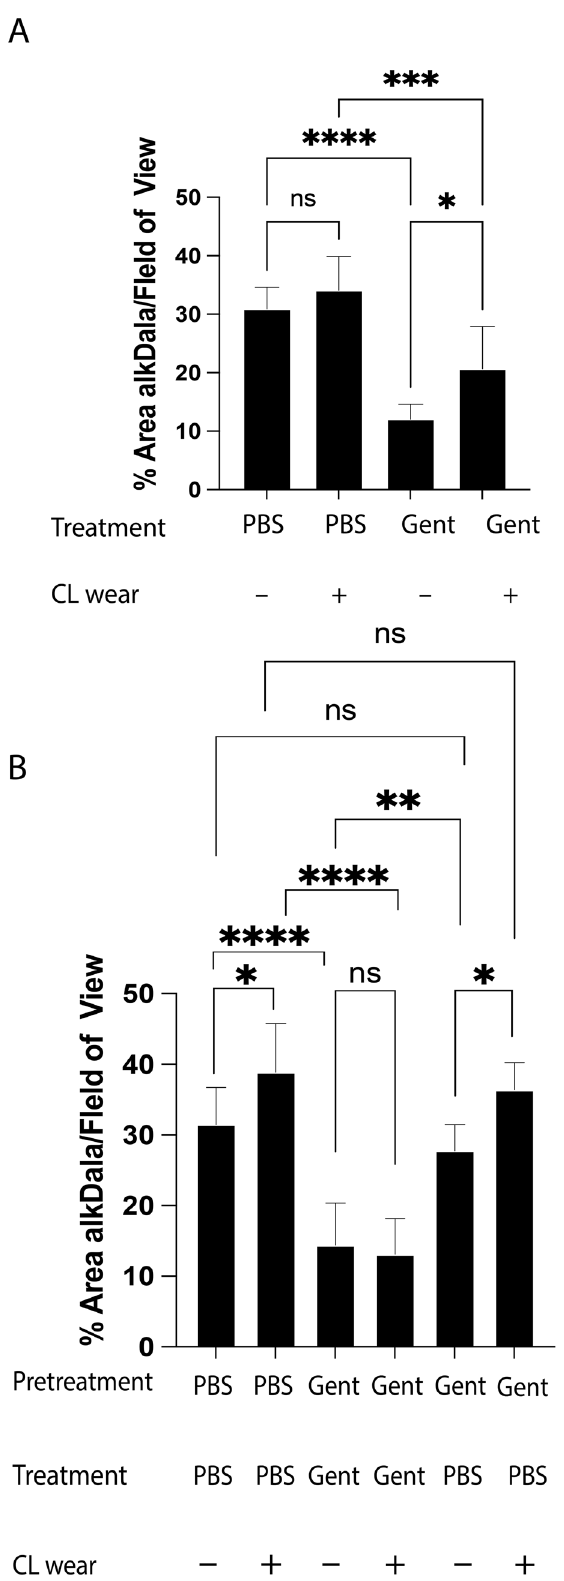
Figure 4. AlkDala labeling of viable conjunctival-associated bacteria. Quantification of alkDala (bacterial) fluorescence on the conjunctiva with ( A ) PBS or gentamicin treatment with contact lens (CL) wear for 24 h or ( B ) PBS or gentamicin pretreatment followed by the same treatments with or without CL wear. Gentamicin treatment/pretreatment was associated with decreased bacterial fluorescence on the conjunctiva with or without CL wear and these changes correlated with corneal CD11c+ changes under most respective conditions (*P < 0.05, ****P < 0.0001, ns not significant; Two-way ANOVA with Tukey’s multiple comparisons